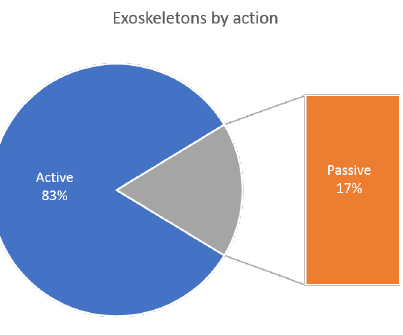
Figure 7. This chart portrays the classification of exoskeletons by the kinds of action given to the